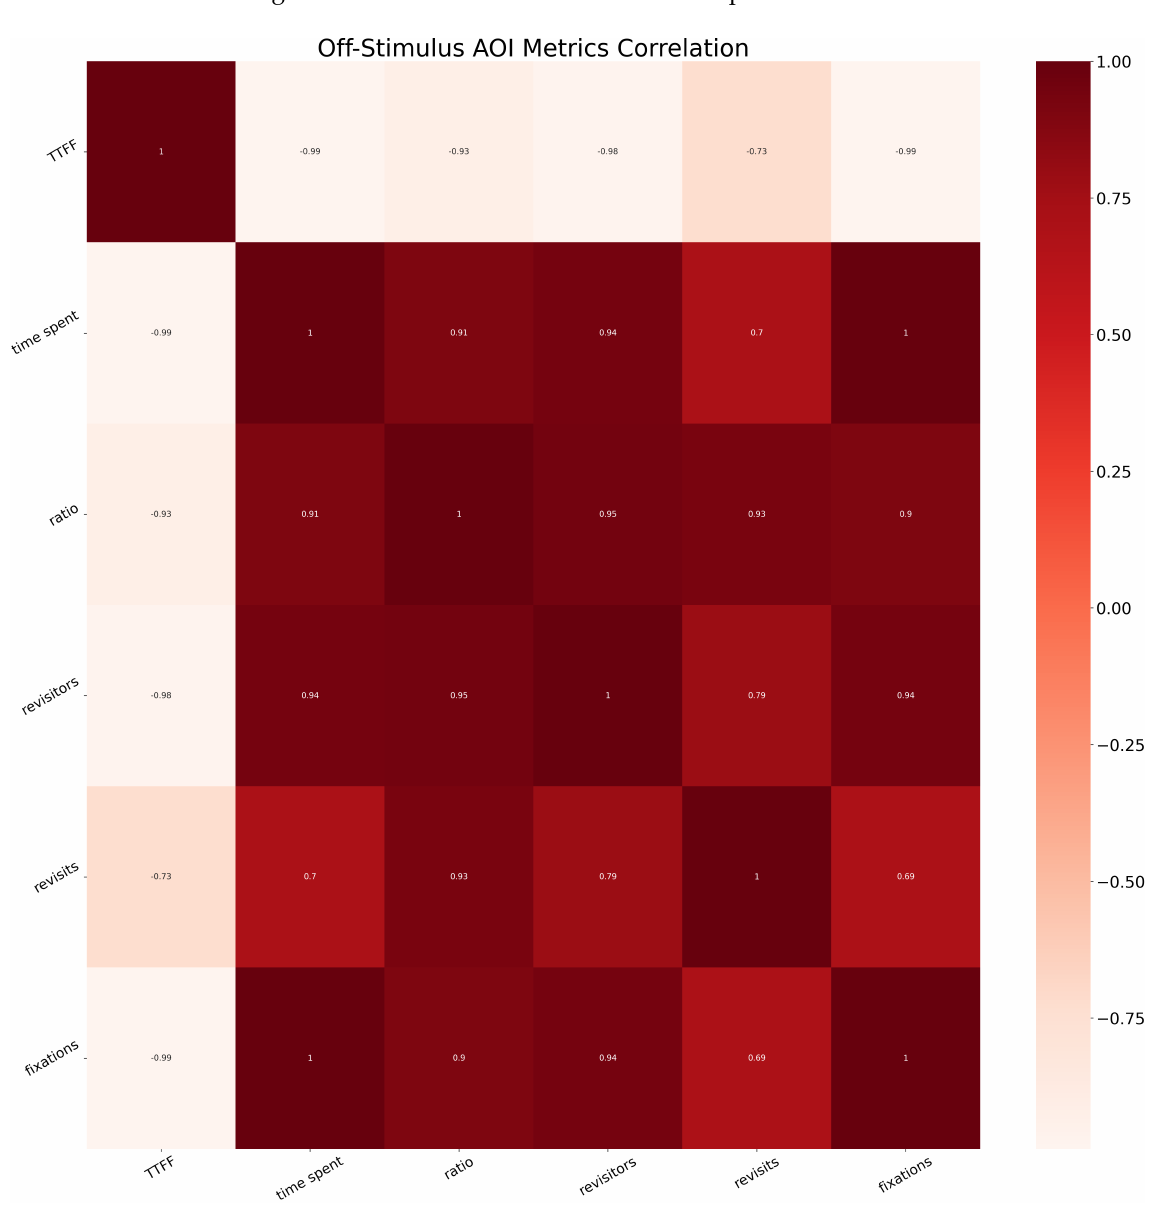
Figure 7. Old website design: area of interest (AOI) metrics Pearson standard correlation